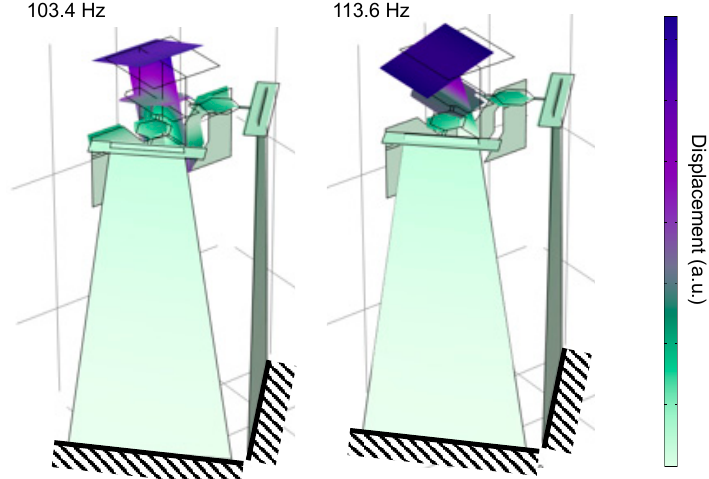
Figure 7. Resonant modes of proposed scanner.